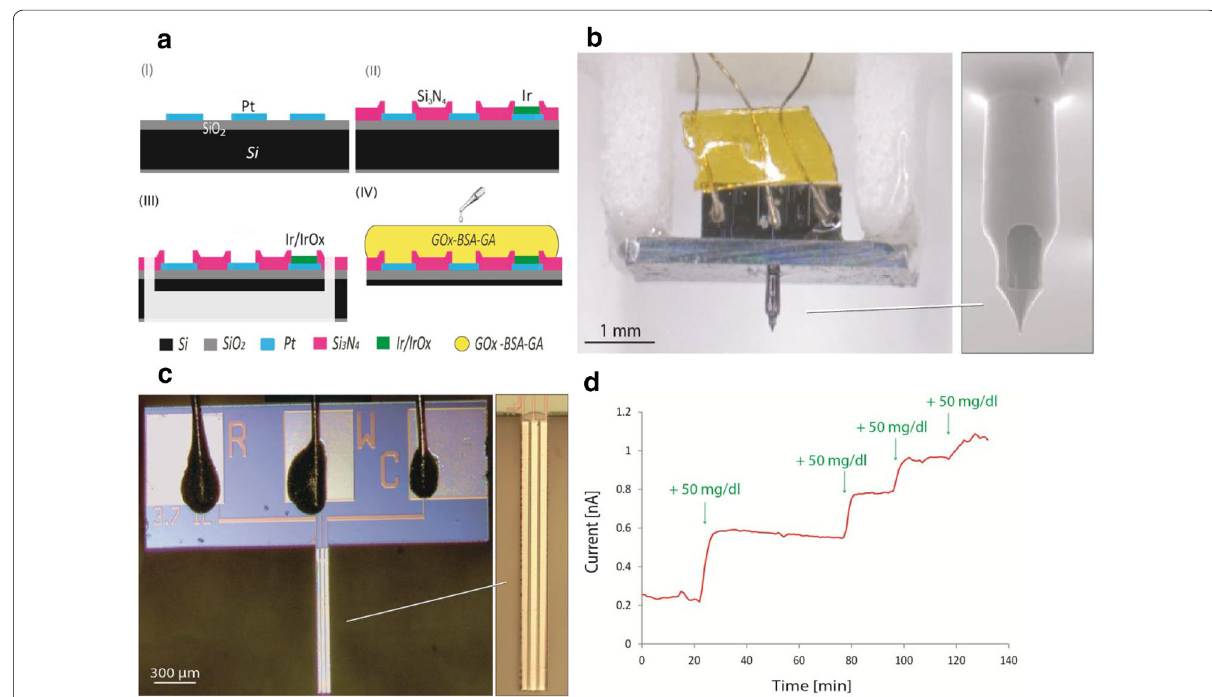
Fig. 2 a Cross-sectional fabrication process of the electrodes on the Si MN. b An optical image of the assembled hollow MN and measurement setups. SEM image of the hollow MN is shown on right hand, c A micrograph of the fabricated electrodes on the Si probe, d Amperometric measurement of glucose by the hollow MN-based sensor (Reproduced with permission [66]. Copyright 2018,